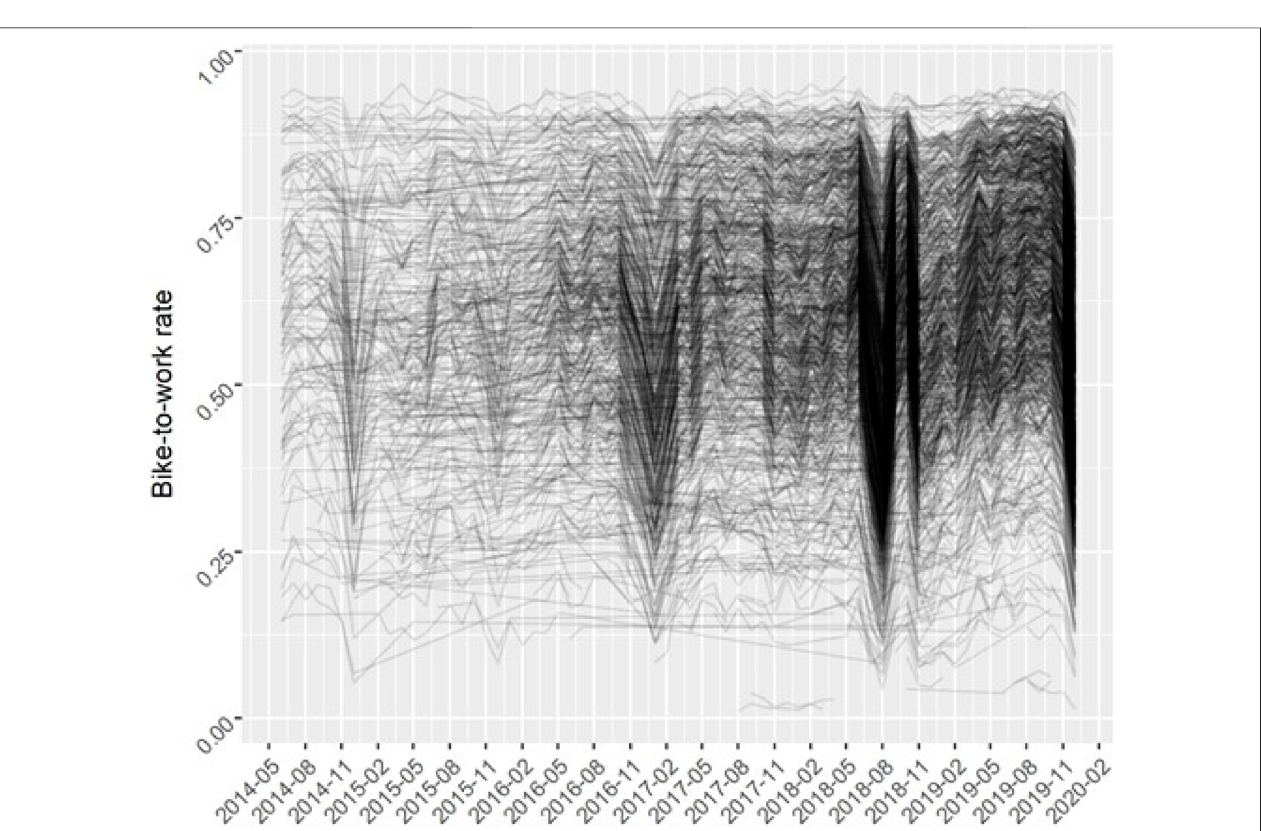
FIGURE 5 | Model predicted person-level bike-to-work rate during the program.